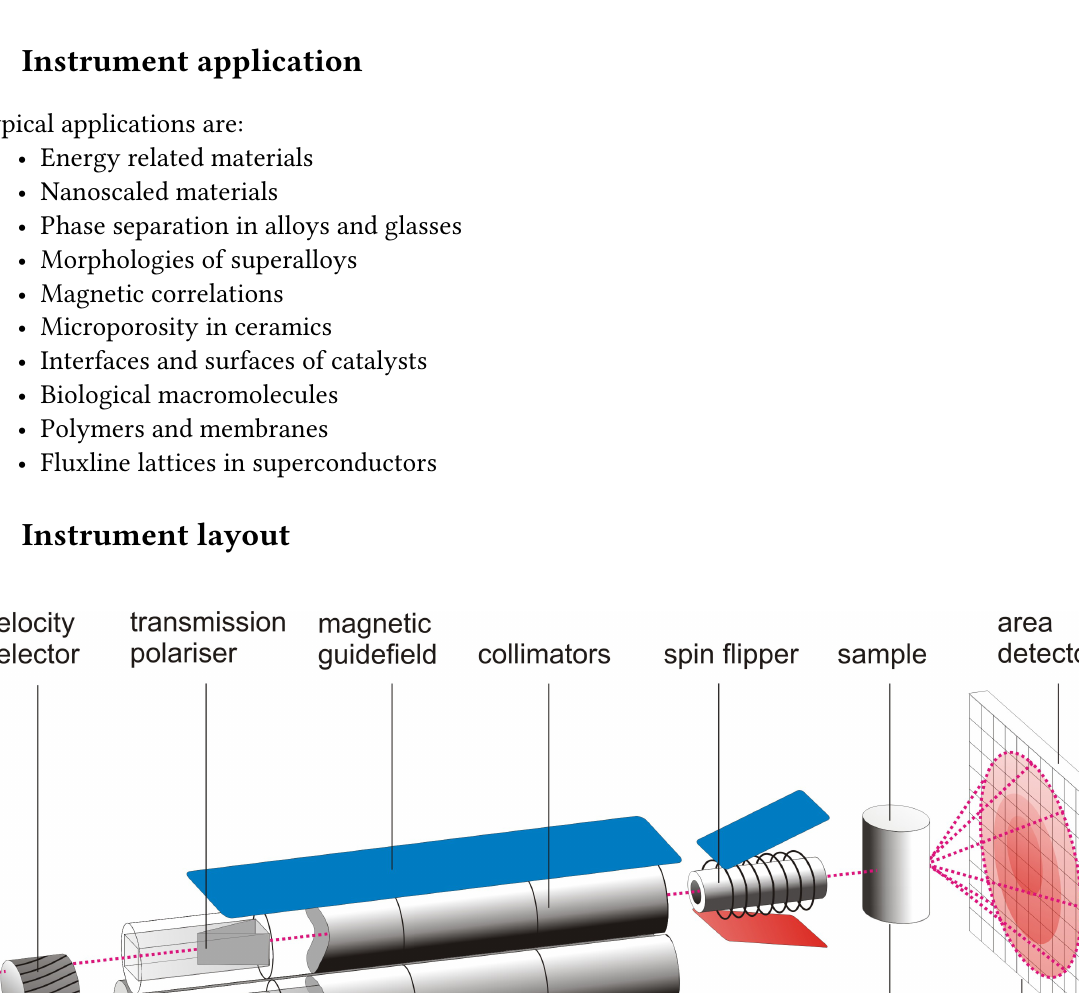
Figure 1: View of V4 model.